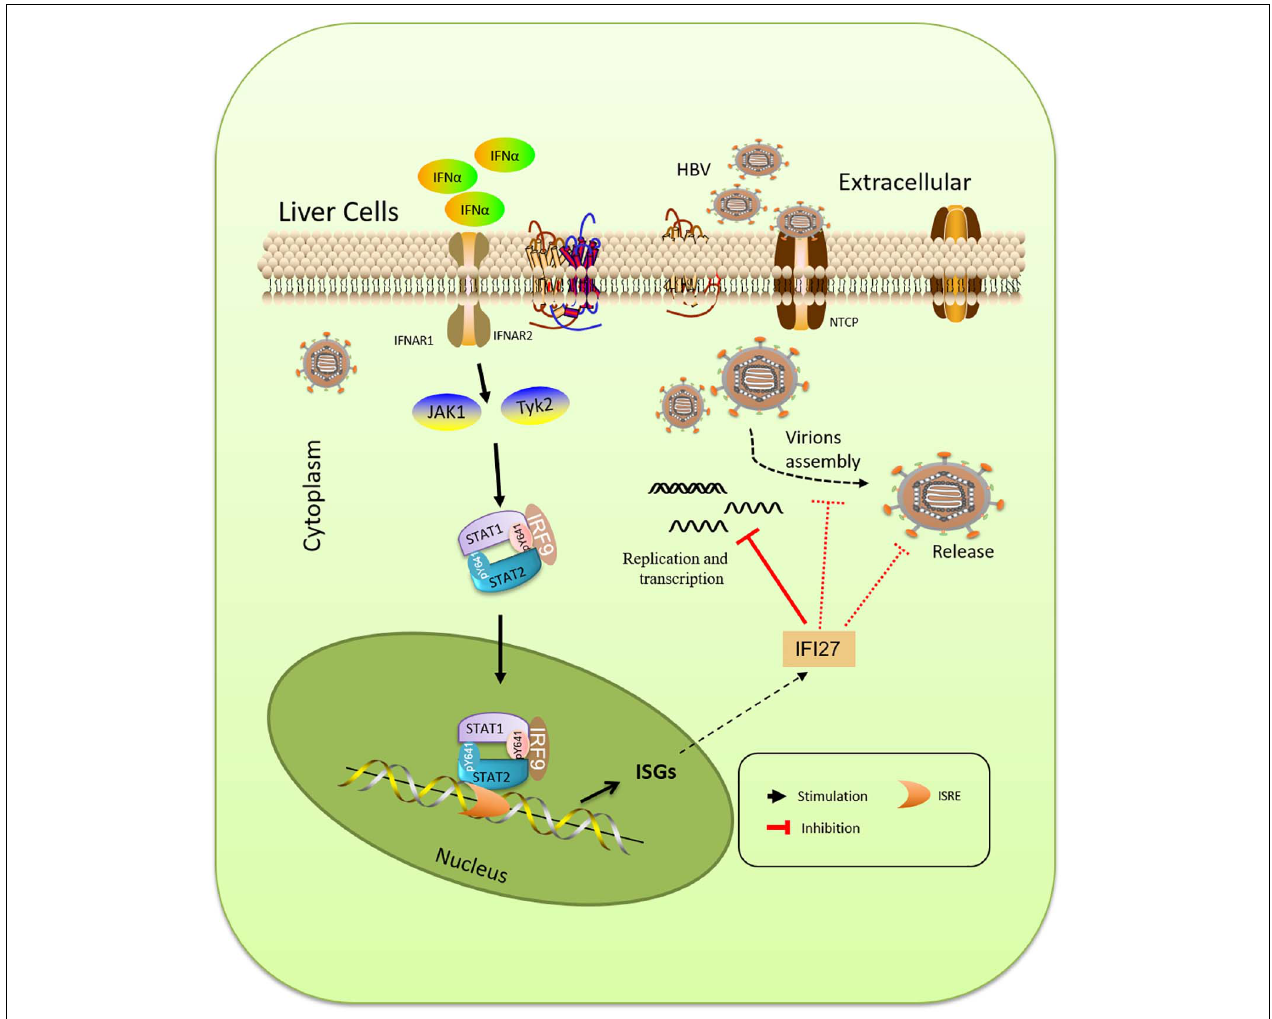
FIGURE 7 | Schematic representation of IFN- α and IFN-stimulated gene (ISG) induction pathway. The type I IFN (IFN- α ) is cascaded via the Janus kinase (JAK)/signal transducer and activator of transcription (STAT) pathway, resulting in the expression of a large spectrum of activated transcriptional ISGs. IFI27 is an ISG that suppresses viral gene expression, prevents transcript production, and decreases the accumulation of viral replicative